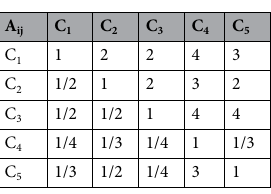
Table 4. Comparative criteria level matrix (Level 2 indicators).